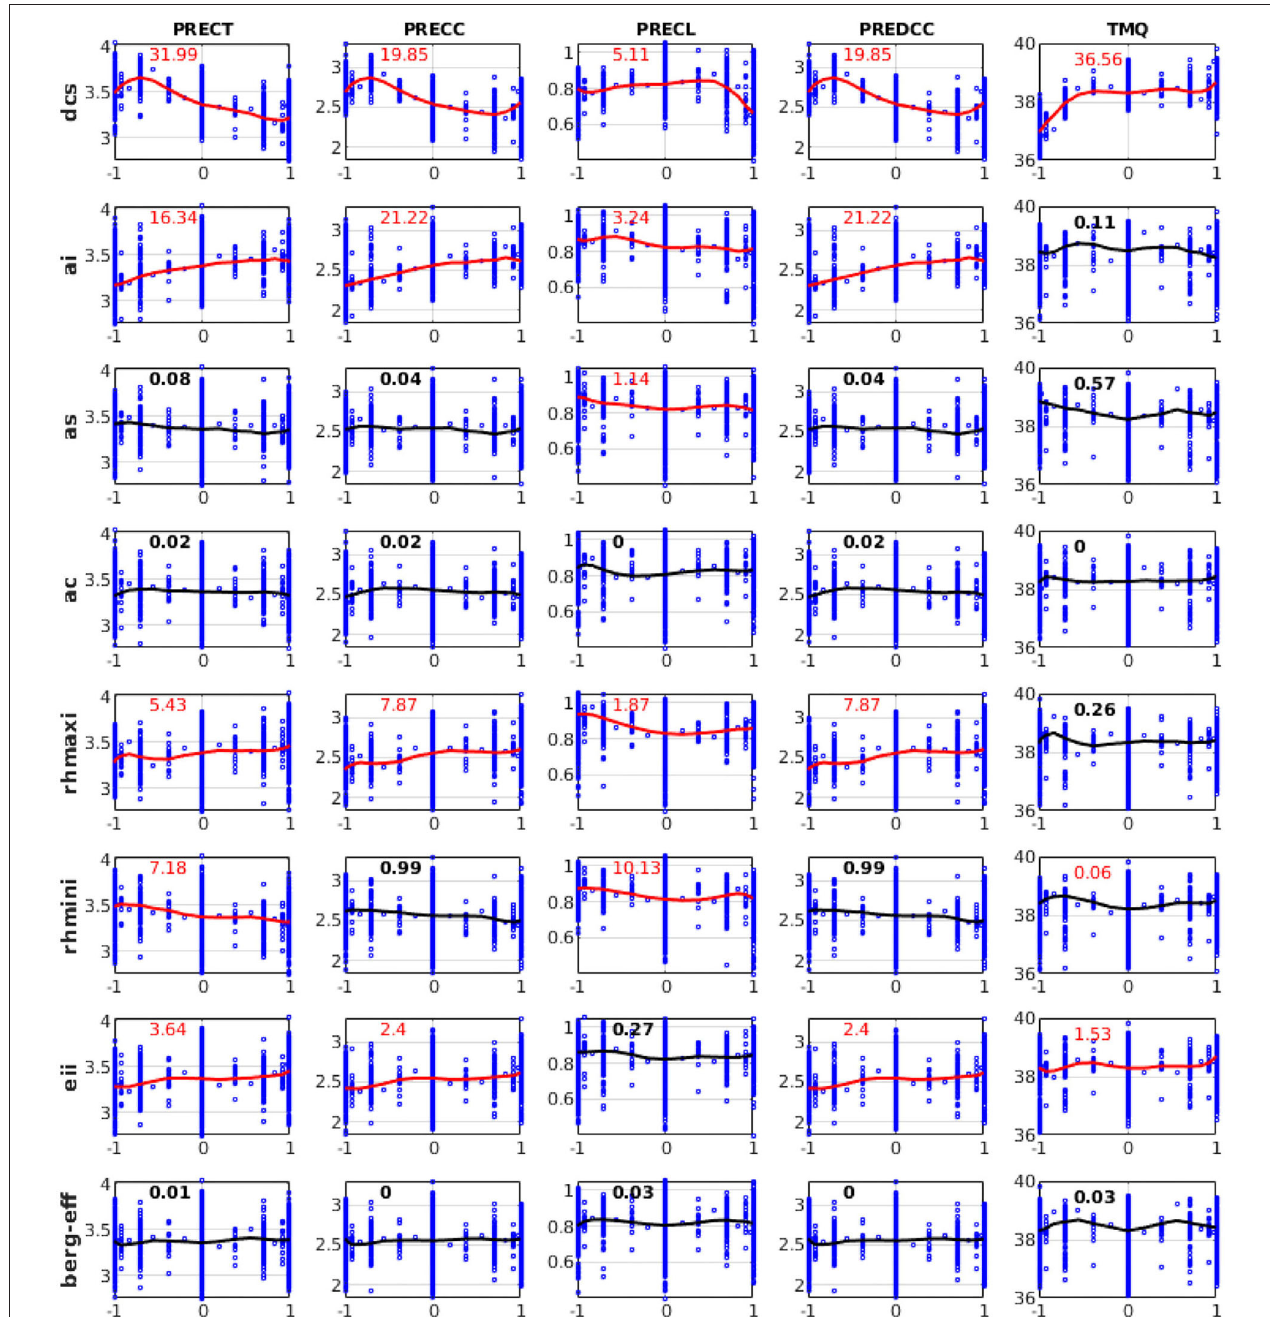
FIGURE 9 | Variation of PRECT, PRECC, PRECL, deep convective precipitation (PREDCC), and total precipitable water (TMQ) in response to perturbations of eight different parameters from 3,937 SCAM6 simulations. The numbers in each plot represent the relative contributions (in %) of each input parameter perturbation to the overall variation of different variables. Red denotes that the contribution is significant ( F -test) at the 95% significance level. The line in each plot corresponds to the response effect of the perturbation of a single parameter when keeping all other parameters at the zero (central) position of their uncertainty ranges for the simulation of that variable. Vertical bars show the range of variation for values of a particular variable in response to the perturbation of other parameters.